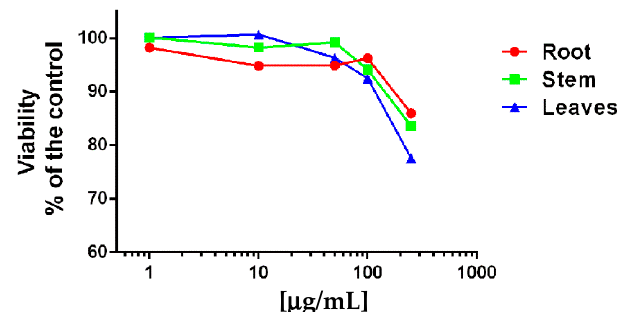
Fig Figure 1. E ff ect of G. tridentata extracts on Raw 264.7 macrophages viability. Cells were exposed to di ff erent concentrations of the extracts, during 24 h and then viability was assessed by the resazurin assay. Data is presented as percentage of untreated cells (control) and represent the mean from three independent